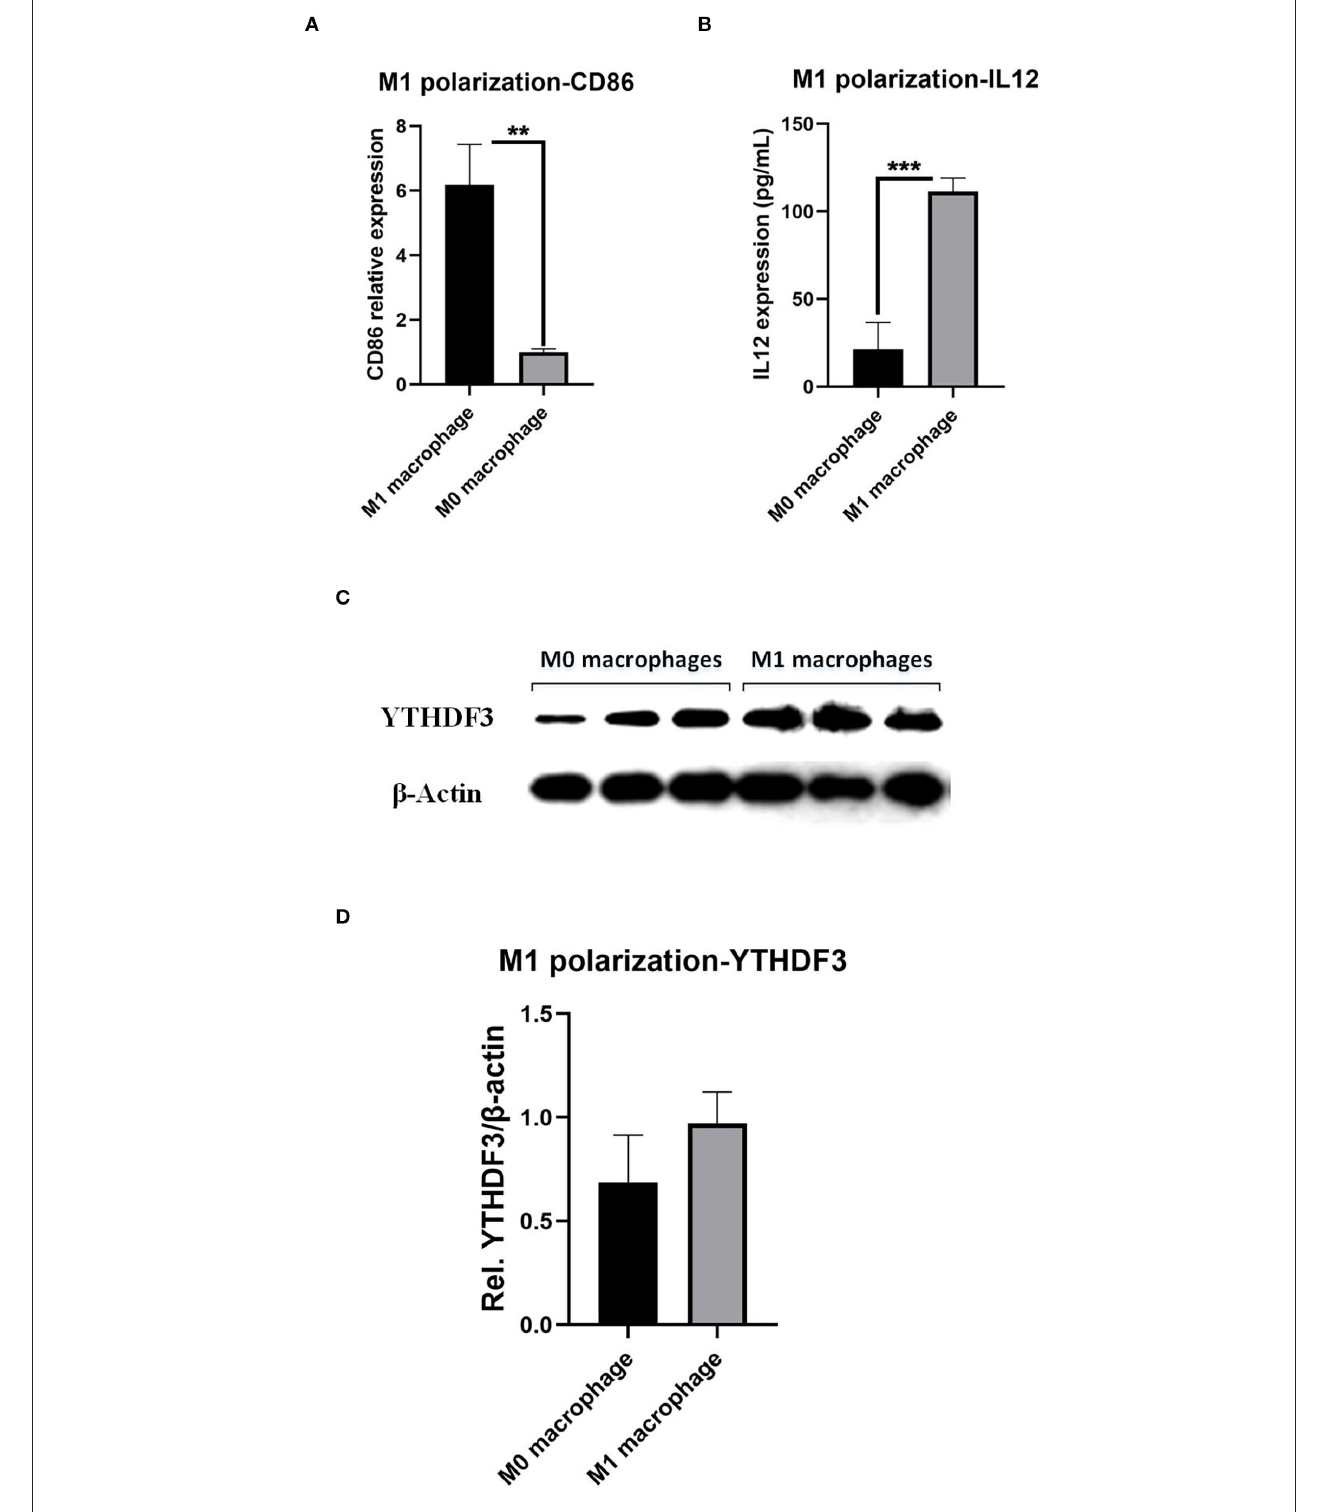
FIGURE 7 | The induction of macrophages M1 polarization and the determination of YTHDF3 expression in M0 and M1 macrophages. (A) The expression of M1 phenotype marker, CD86 , in M0 macrophages and LPS/IFN- γ induced M1 macrophages, measured by RT-qPCR; (B) The expression of M1 phenotype marker,